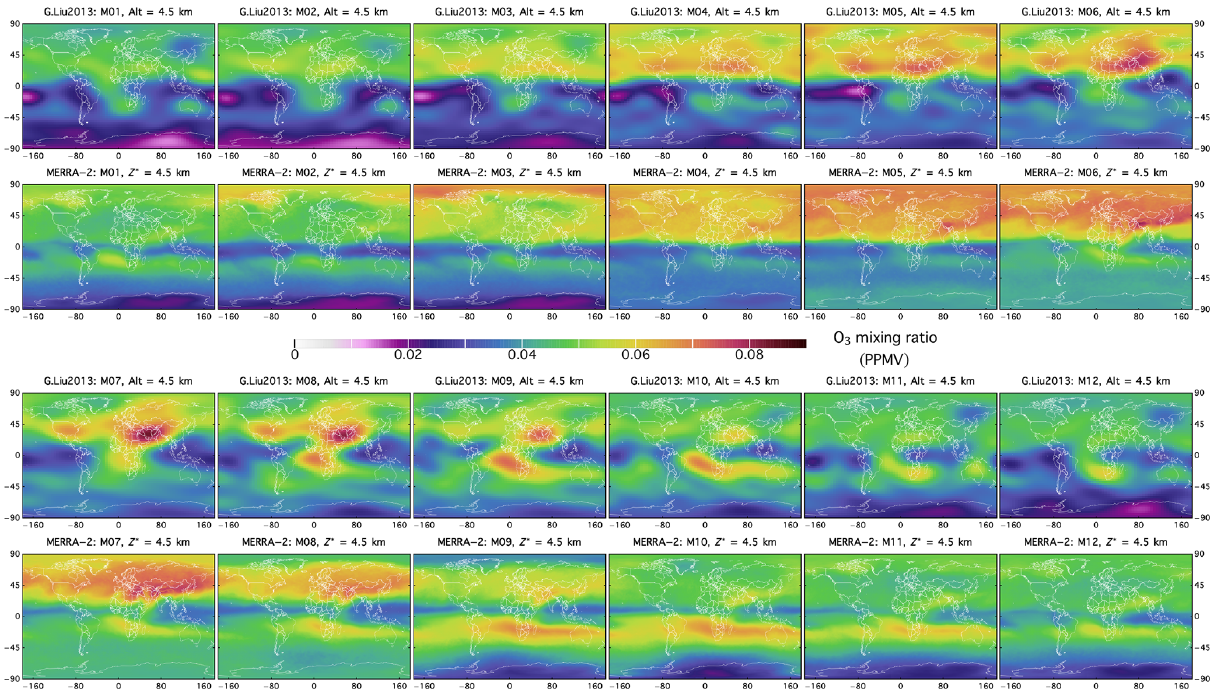
Figure 13. MERRA-2 climatological O 3 concentration (i.e., mixing ratio in parts per million by volume) at Z ∗ = 4 . 5km for the 12 months (January–June, upper panels; July–December, lower panels) of the year and comparison with the tropospheric O 3 profile climatology of G. Liu et al. (2013). Note that the mixing ratio of G. Liu et al. (2013) is at 4.5km